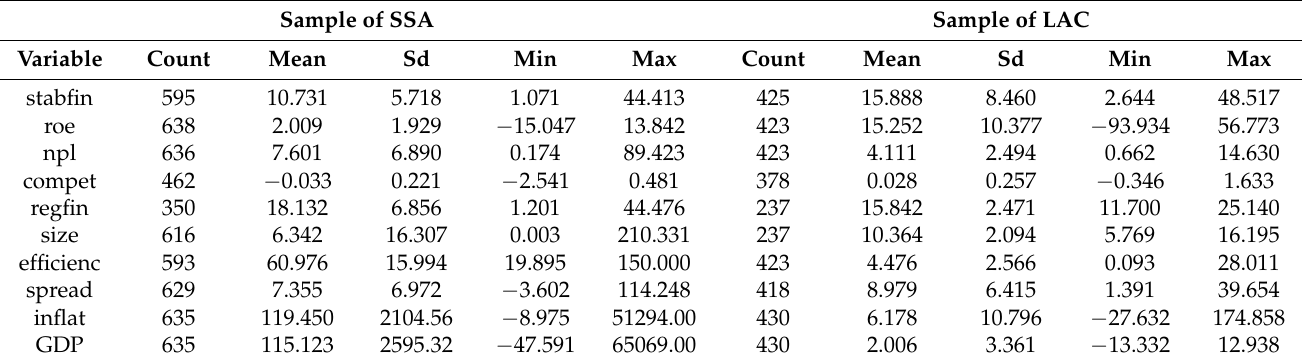
Table 4. Descriptive statistics of bank-specific and macroeconomic